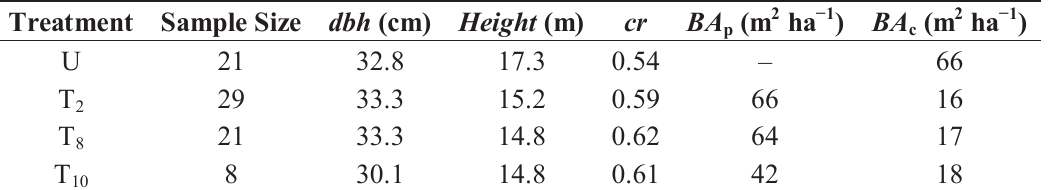
Table 1. Mean breast height (1.37 m) diameter ( dbh ), height ( h ), crown ratio ( cr ), pre-treatment basal area ( BA four different stands (U, T